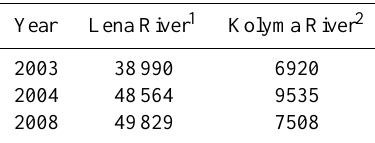
Table 4. Average river discharge, m 3 s − 1 , during the summer sea- son